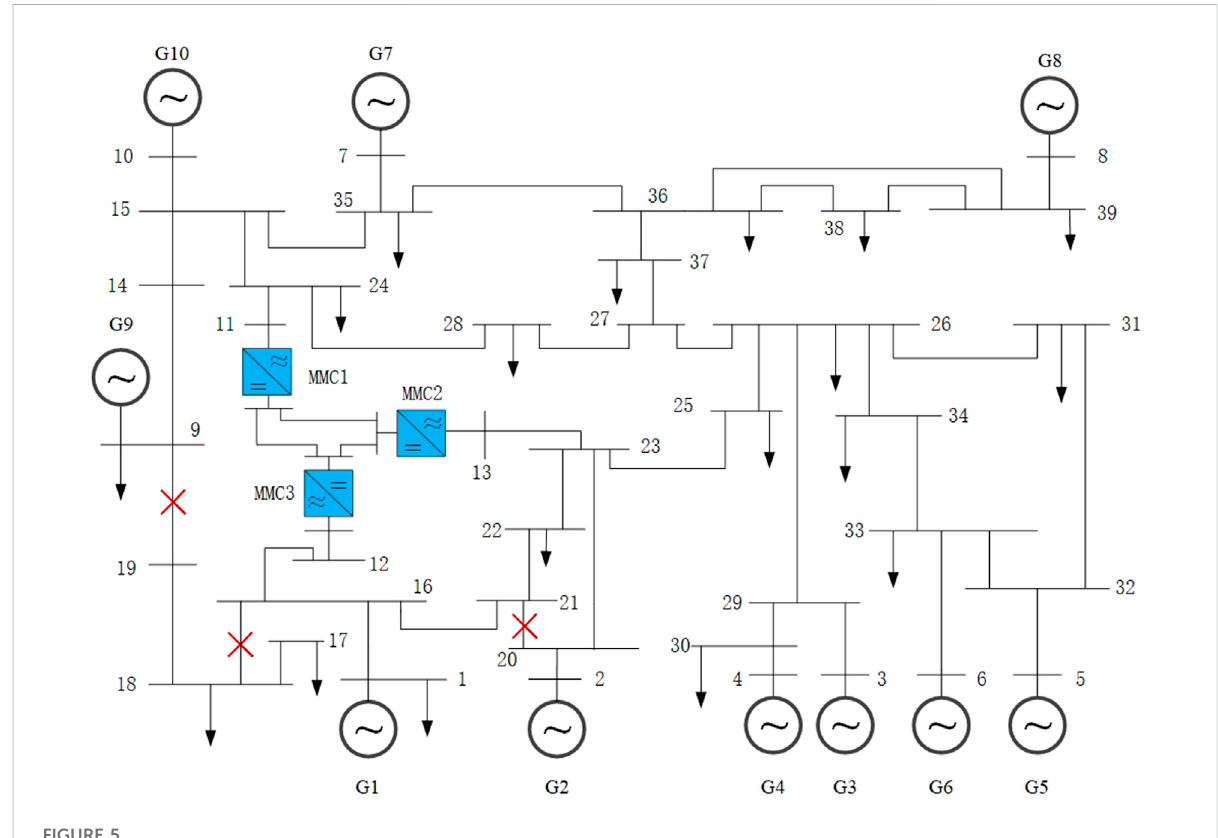
FIGURE 5 The framework of the MMC-MTDC test model.